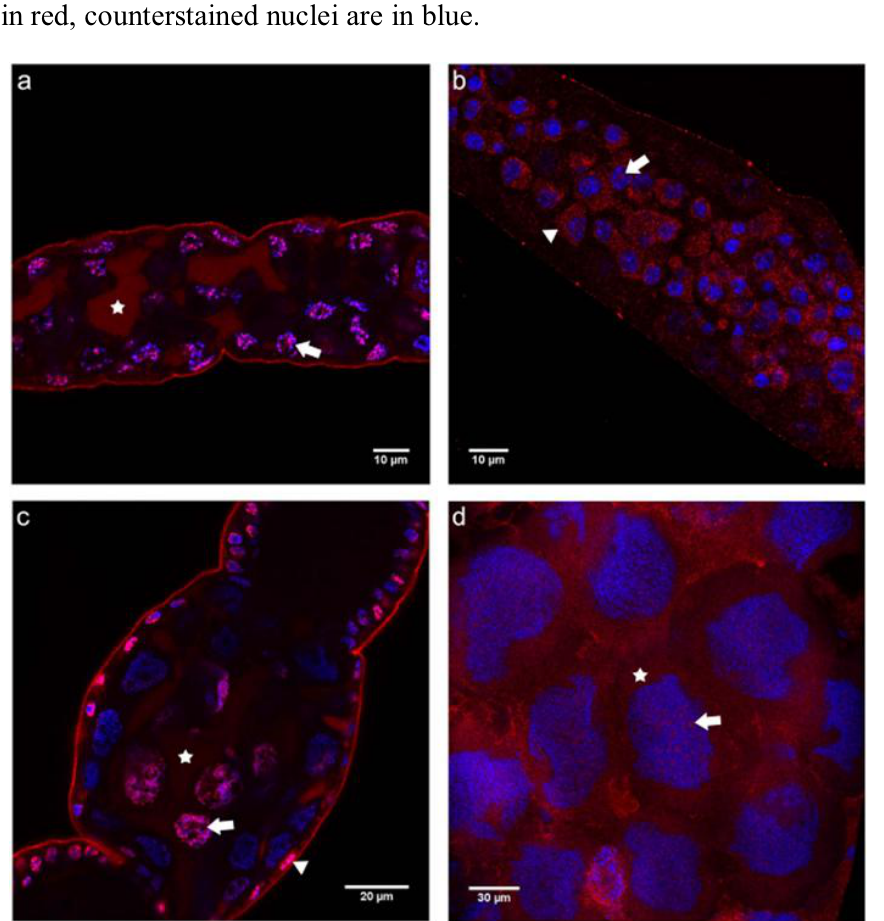
Figure 6. Immunofluorescence analysis with an antibody raised against the C-terminal domain of E-cadherin (E-cadC) on ovaries of egg-laying queens ( a and c ) and queenless workers ( b and d ). Shown are single confocal section images of 1 (cid:541) m thickness. ( a ) Germarium of queen ovariole showing homogeneous, extensive cytoplasmic labeling in the periphery (asterisk) and strong foci in the nuclei (arrow). ( b ) An almost complete inversion image to that seen in queens was apparent in the germarium of worker ovarioles, with E-cadC dispersed in the perinuclear cytoplasm (arrowhead) and as smaller dots in the nuclei (arrow). ( c ) In the trophic chamber of previtellogenic follicles in queen ovarioles, nurse cells continued to show the diffuse E-cadC localization in the peripheral cytoplasm (asterisk), as well as maintaining the strong nuclear signal (arrow), especially so in those closer to the oocyte (partially apparent at lower left side). ( d ) Trophocytes of previtellogenic worker follicles continued to show a dispersed distribution of E-cadN throughout the cytoplasm (asterisk), but with a tendency to become more concentrated in the cortex. The nuclei showed innumerous E-cadC dots (arrow). E-cadC immunoreactivity is shown in red, counterstained nuclei are in blue.